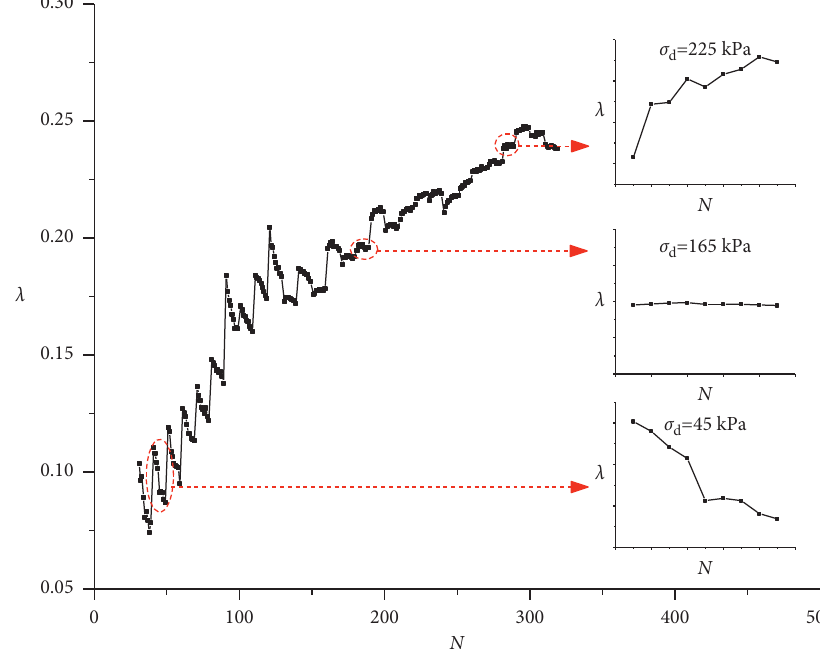
Figure 12: Damping ratio versus cycle number curves under different dynamic stress fitting curve results. The stable and failure curves are expressed in the following equations, respectively.